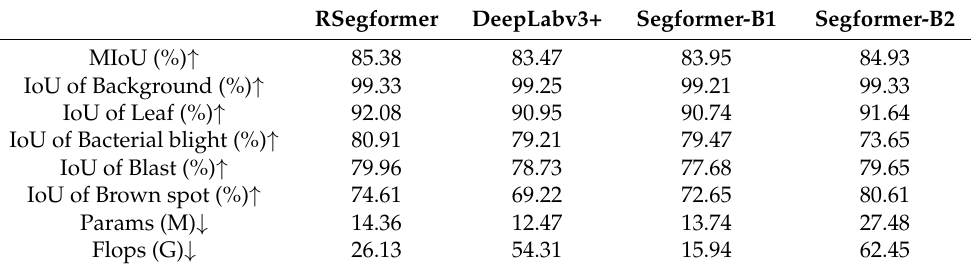
Table 4. Comparison of Deeplabv3+, Segformer and RSegformer models.